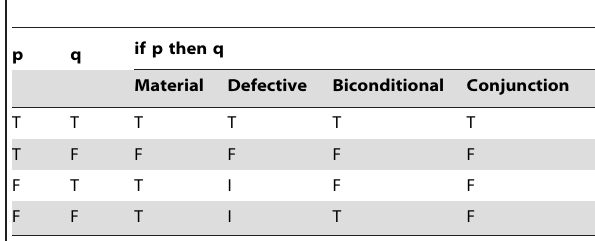
Table 2. Truth tables for the material, defective, biconditional and conjunction interpretations of the conditional (T – true; F – false; I –